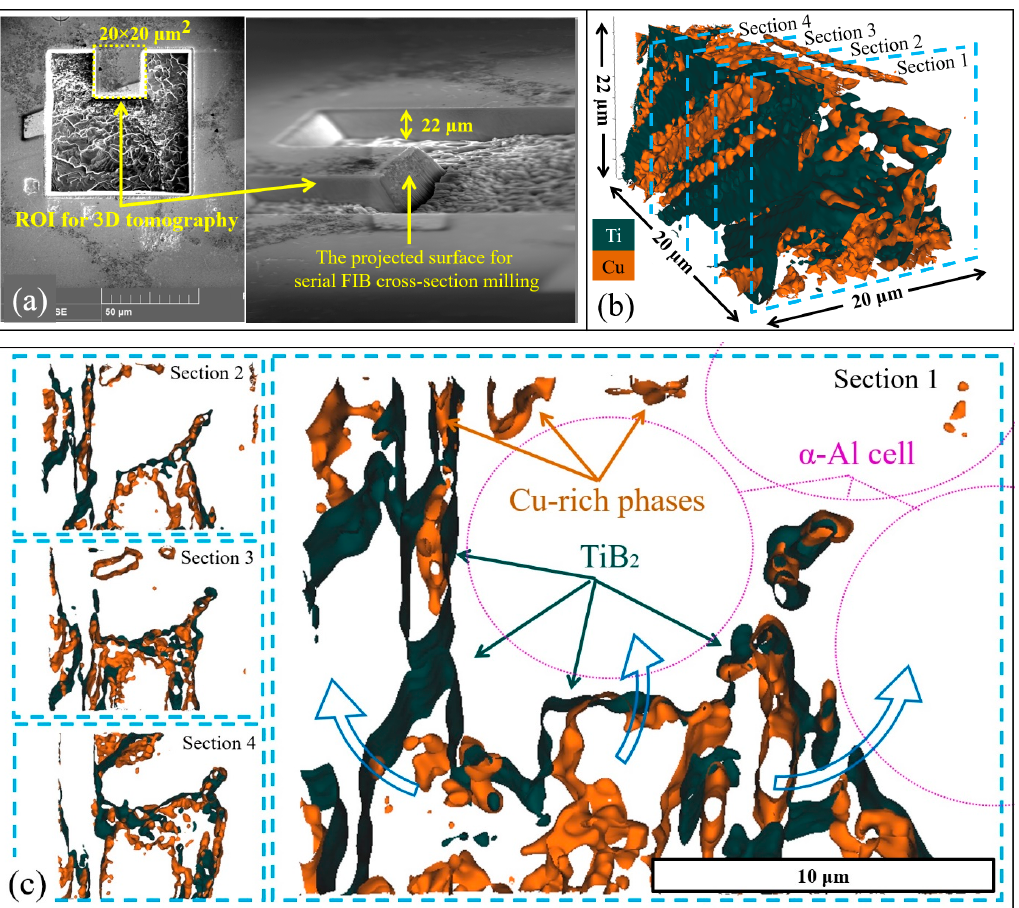
Figure 6. ( a ) Scanning electron image showing the volumetric ROI in the as-cast A205 alloy. ( b ) 3D reconstruction of Cu-rich phases and TiB 2 particles from energy dispersive spectroscopy (EDS) maps of the selected ROI. ( c ) Four 3D cross-sections with 5 μ m spacing between each other (section 1 is expanded).